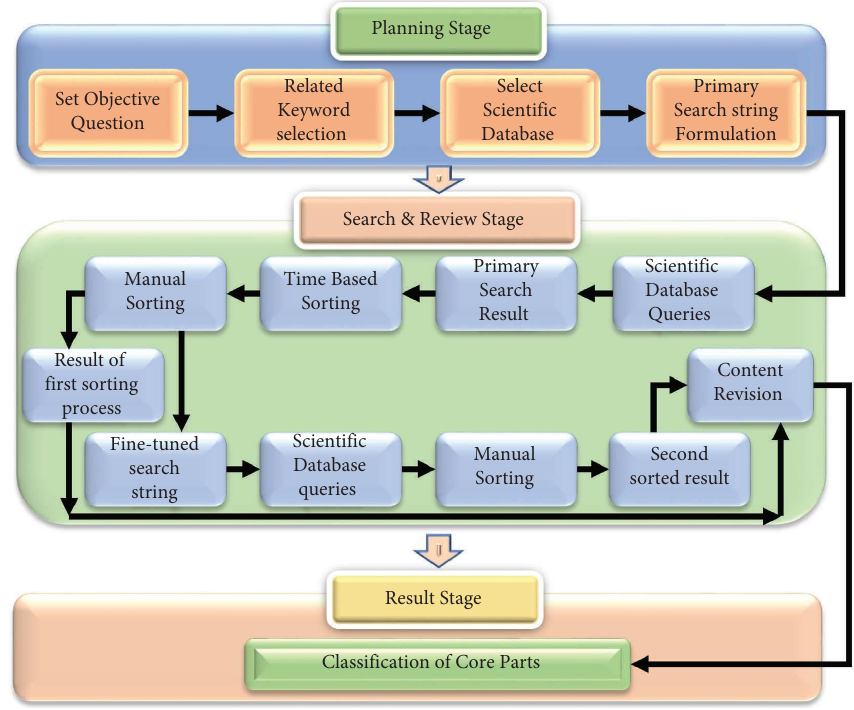
Figure 2: Research method in detail.